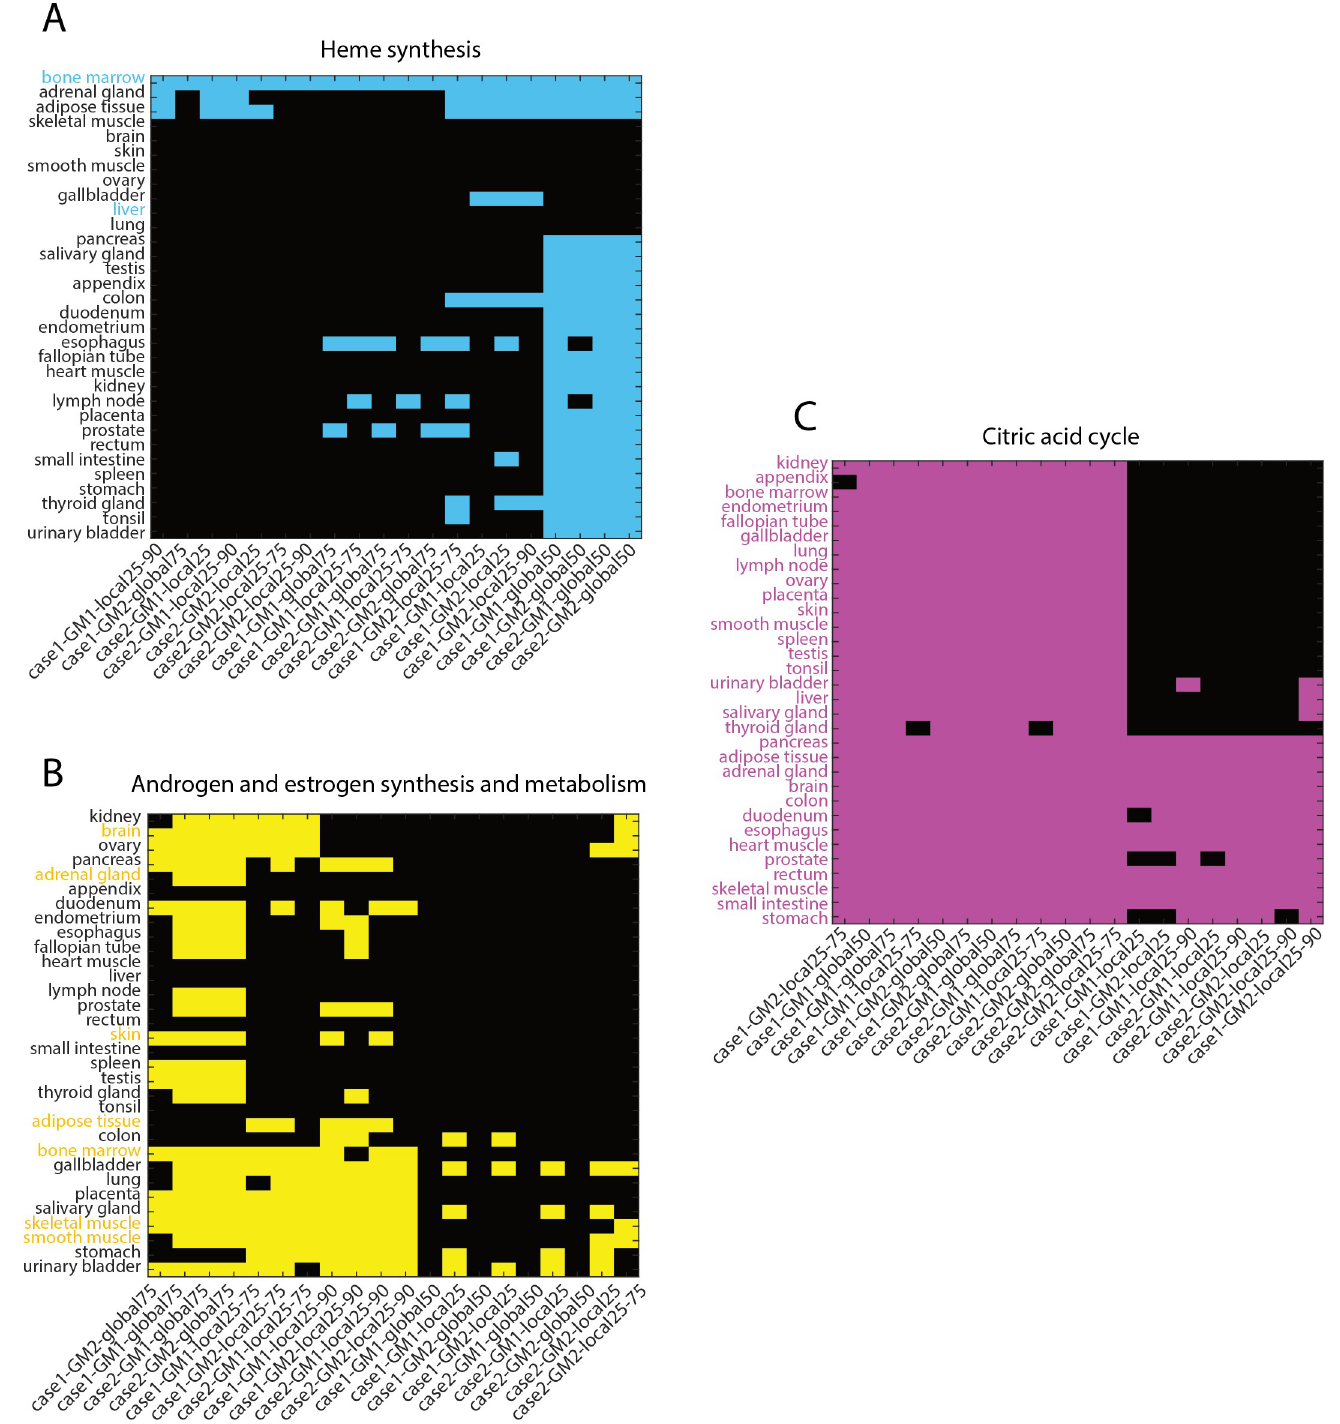
Fig 5. Comparison of active reaction lists obtained using different thresholding methods with manually-curated resource. Tissues where pathways are known to be active are bolded and colored on the y-axis and colored on the binary heatmap. (A) All thresholding methods accurately capture heme synthesis in bone marrow but not in liver. Global50 enriches the pathway in many other tissues but the pathway is known to occur only in bone marrow and liver. (B) Androgen and estrogen synthesis and metabolism is known to occur in brain, adrenal gland, skin, adipose tissue, bone marrow, skeletal muscle, and smooth muscle. Global75 enriches the pathway in higher number of tissues; and global50 and local25 does not enrich it in lower number of tissues compared to other methods. (C) Citric acid cycle is known to occur in all tissues but local25 and local25-90 does not enrich in many of the tissues compared to other methods. Thus, suggesting that local25-75 performs better than other thresholding methods in all pathway types together (Fig F in S1